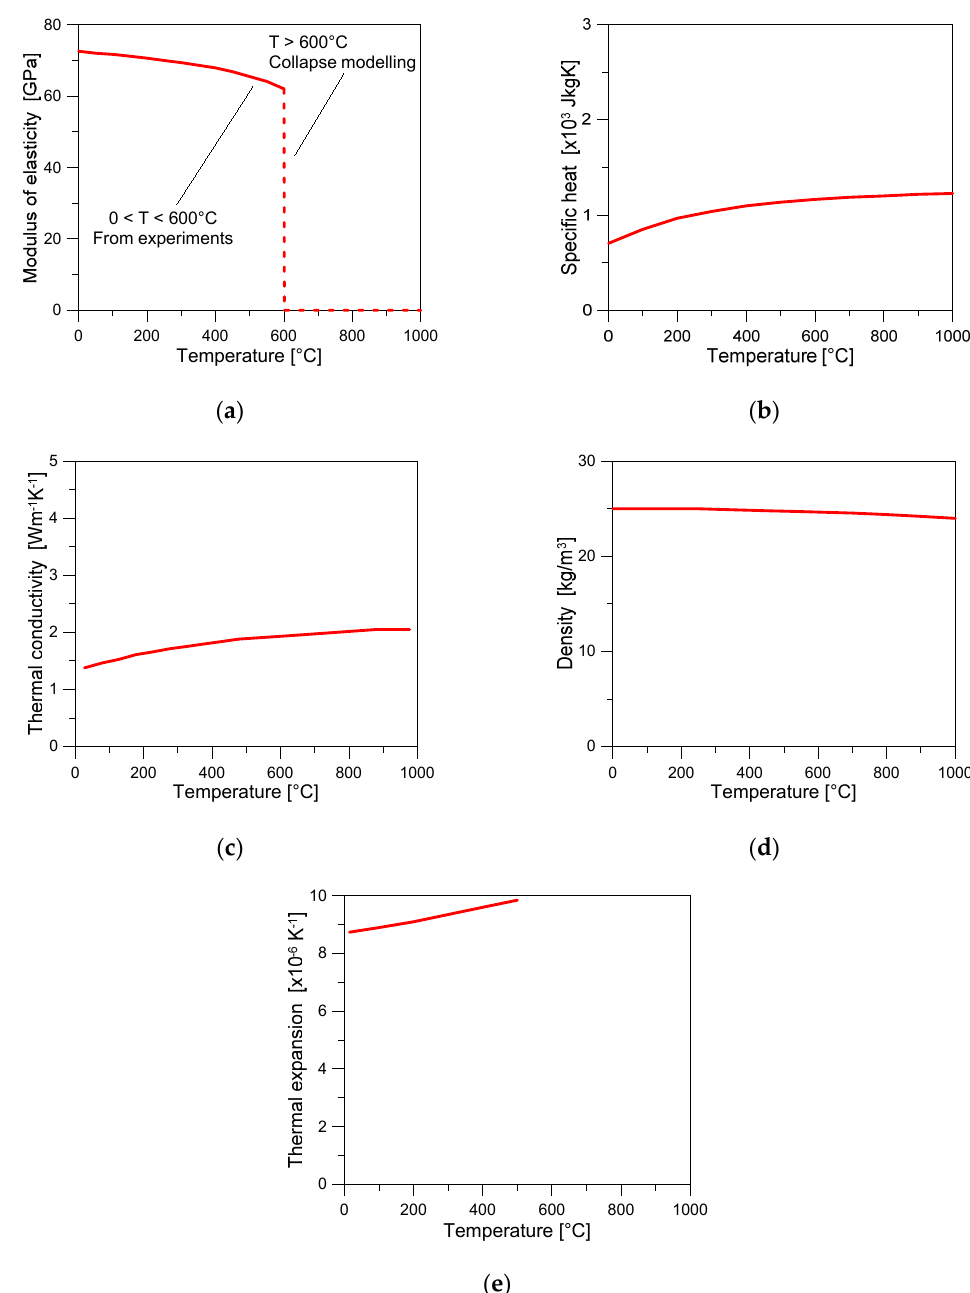
Figure 8. Selected glass material properties for ordinary soda-lime annealed glass, with evidence of their sensitivity to temperature variations: ( a ) modulus of elasticity; ( b ) specific heat; ( c ) thermal conductivity; ( d ) density; ( e ) thermal expansion coefficient (figure adapted from [136] under the terms and conditions of a CC-BY copyright license agreement).